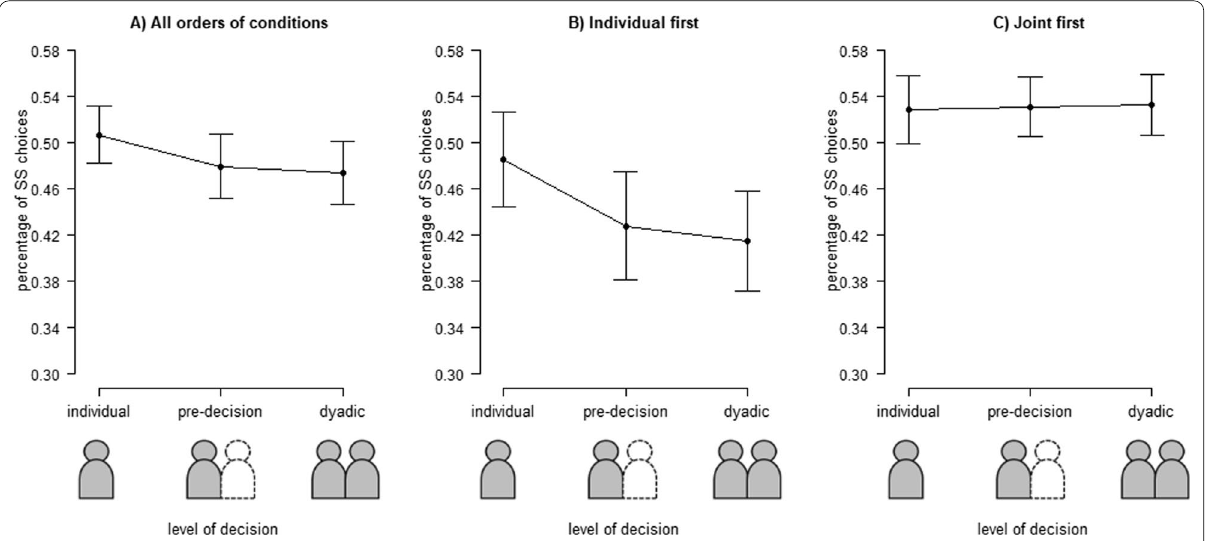
Fig. 2 Results of Experiment 1. Relative frequency of SS choices in different levels of decision-making (individual decision, pre-decision, dyadic decision). Error bars indicate standard errors of the mean. The results are presented ( A ) without separation by the orders of conditions, ( B ) separately for the condition individual first, and ( C ) separately for the condition joint